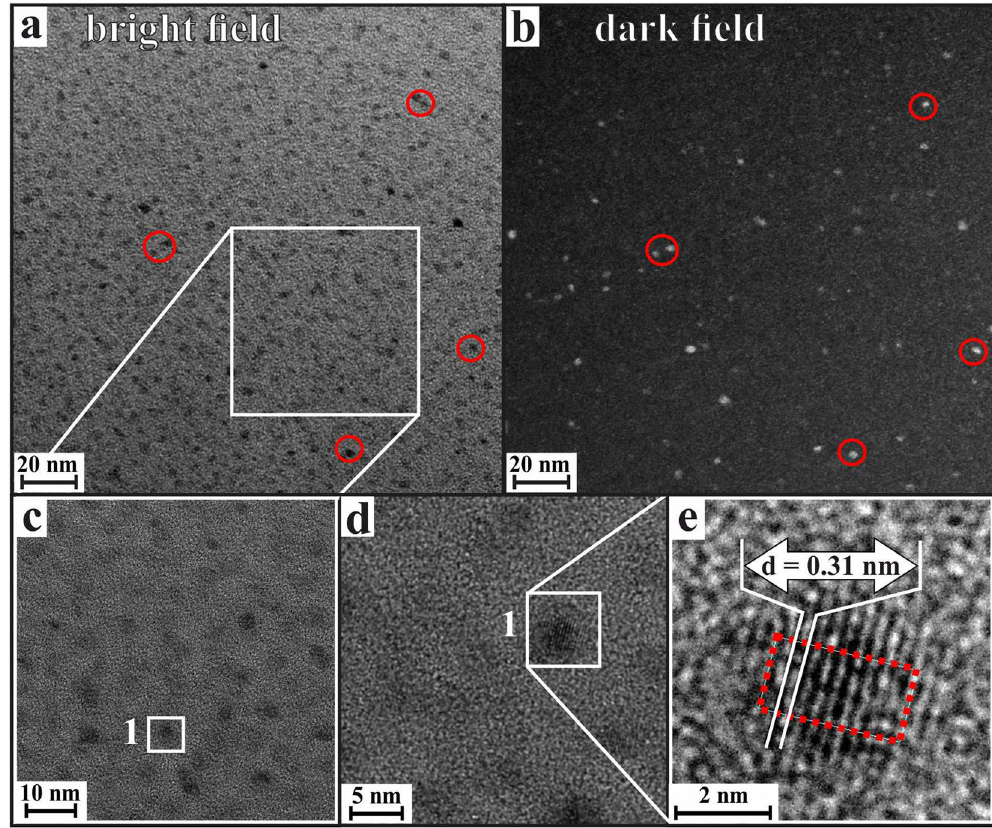
Figure 4. ( a ) TEM bright field micrograph of a LAS glass sample thermally treated at 725 °C for t = 1.75 h. ( b ) Same sample position: TEM dark field micrograph shows crystallinity of the nanoscaled inclusions. ( c – e ) Stepwise magnification of the inset in ( a ). The lattice plane distance correlates to the[011]-crystallographic plane of t-ZrO 2